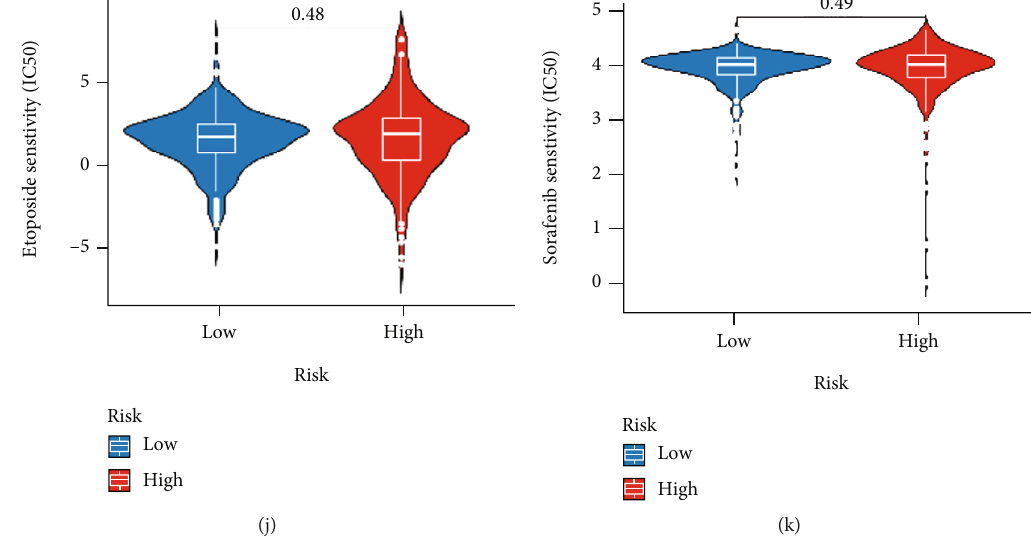
Figure 5: Construction of a nomogram and comprehensive validation of Ferr-LPM. (a) Nomogram for both clinicopathological factors and Ferr-LPM. (b) Calibration curve of the nomogram for predicting 1-, 3-, 5-, and 10-year OS. (c) The ROC curves for 1-, 3-, 5-, and 10-year nomograms. (d – k) The relationship between LPM_score and chemotherapy